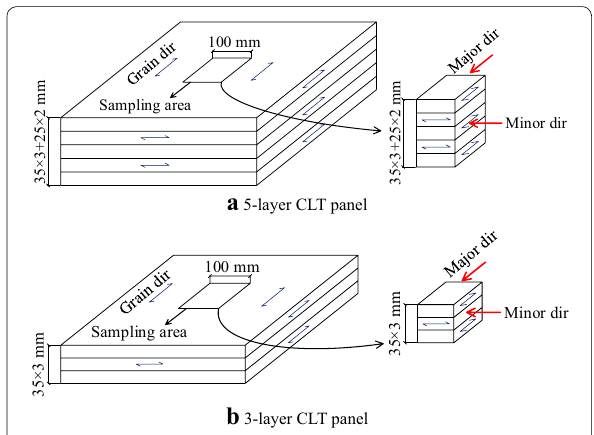
Fig. 2 Rectangular specimens extracted from the 3- or 5-layer CLT panels